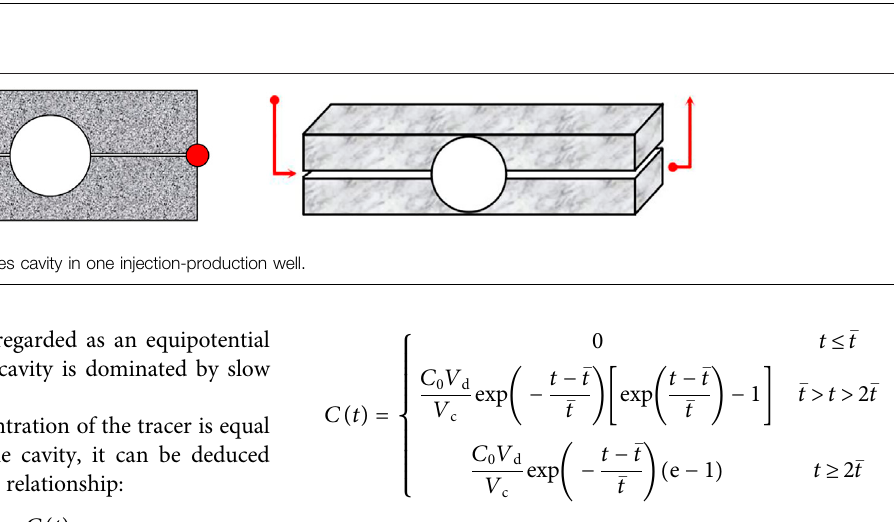
FIGURE 6 | Tracer output curve of interwell single cavity under different parameters. (A) different V c ( Q =15 m 3 /d) (B) different Q ( V c =200 m 3 ).